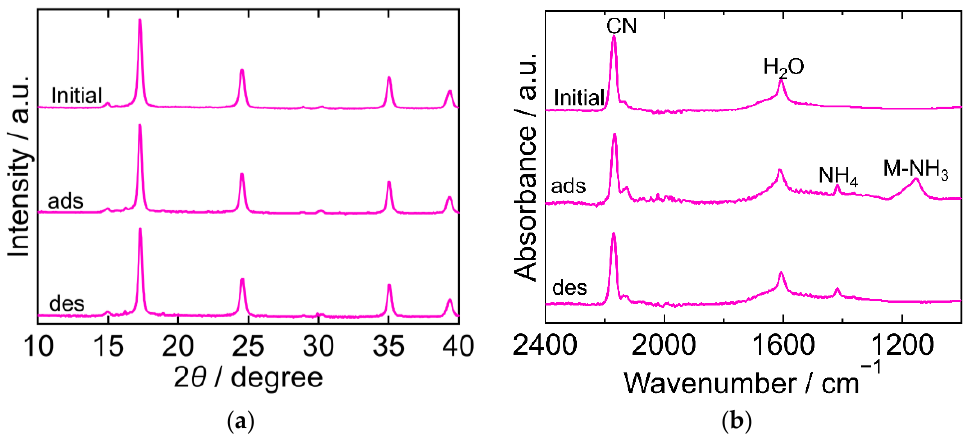
Figure 3. XRD patterns ( a ) and FTIR spectra ( b ) of cobalt hexacyanocobaltate (CoHCC). “Initial” sample is literally the sample before adsorption. The samples after adsorption and desorption are denoted by “ads” and “des”, respectively. The measurements were performed at ambient temperature.